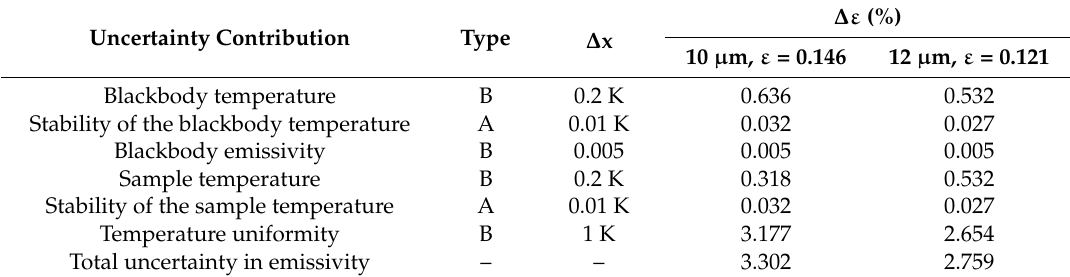
Table 1. Standard uncertainty of the emissivity of the stainless steel at 213